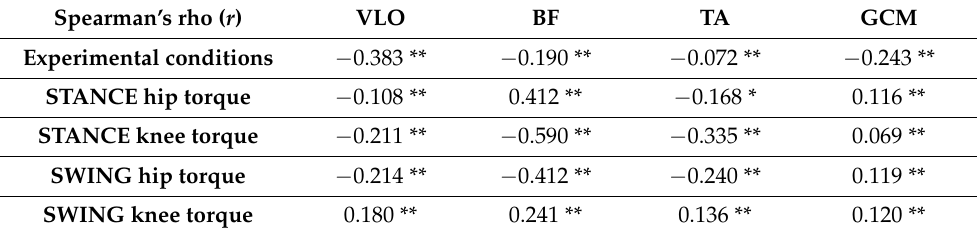
Table 3. Correlation between electromyography and torque data during different robot-assisted gait training